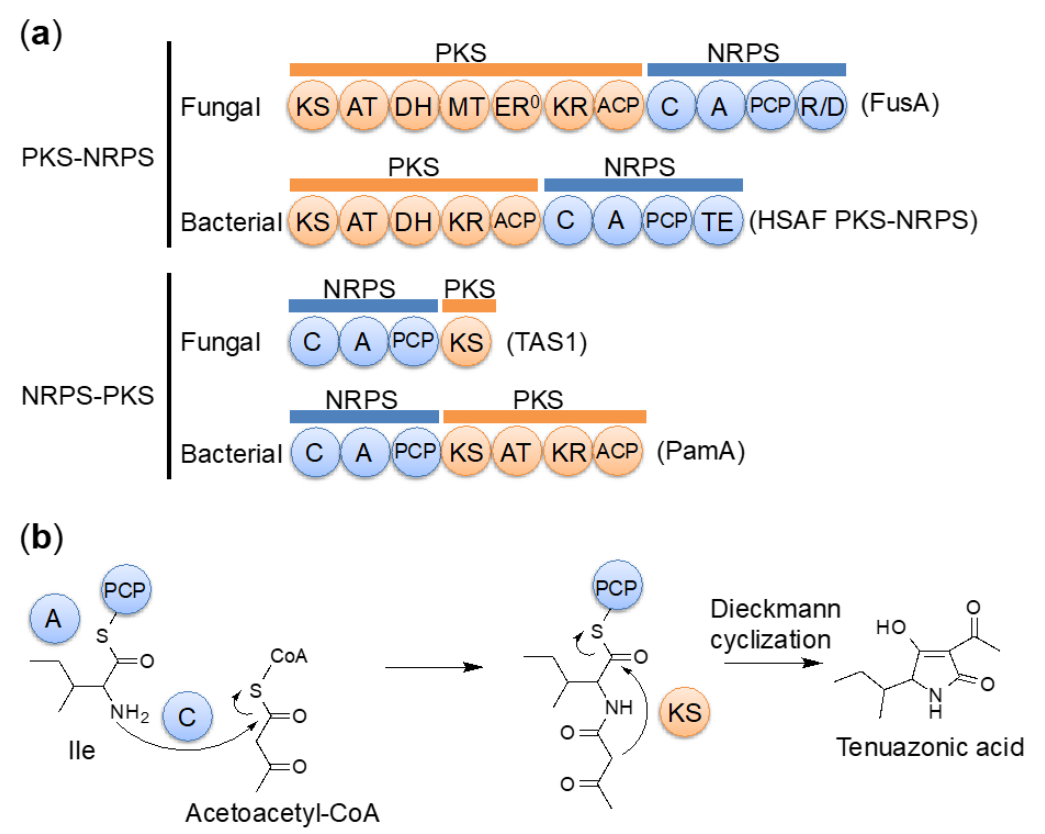
Figure 5. Tenuazonic acid (TeA) biosynthesis. ( a ) Comparison of domain structures. ( b ) Biosynthetic pathway of